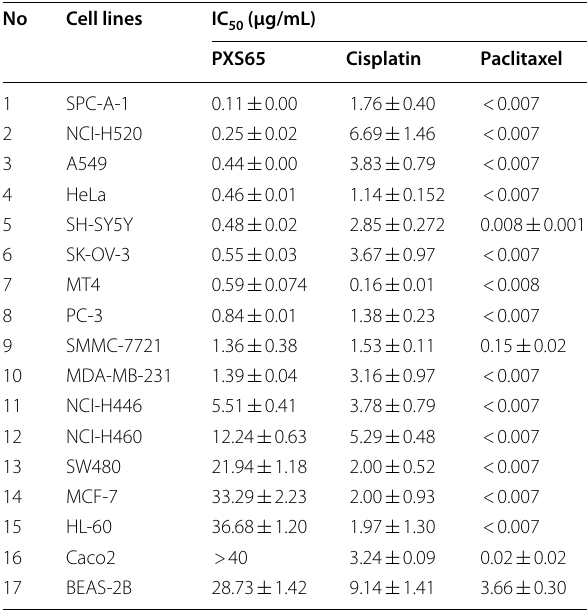
Table 1 Cytotoxicity of the EtOH extract (PXS65) of A. sinensis after water extraction against 16 cancer cell lines and the normal human bronchial epithelial BEAS‑2B cell line